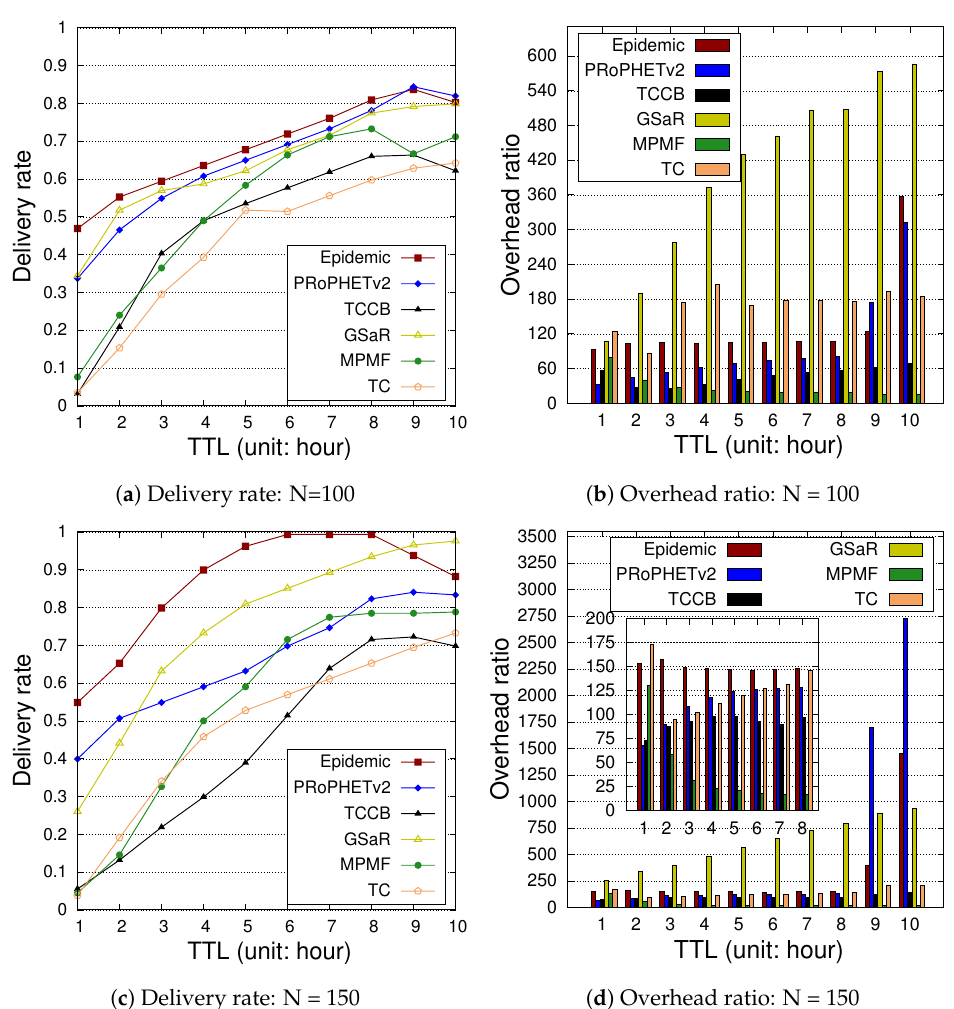
Figure 11. Performance comparison of MPMF in TVCM trace ( W 0 = 0.5, L = 20, (cid:101) = 60, α = 0.6, and buffer size = 10